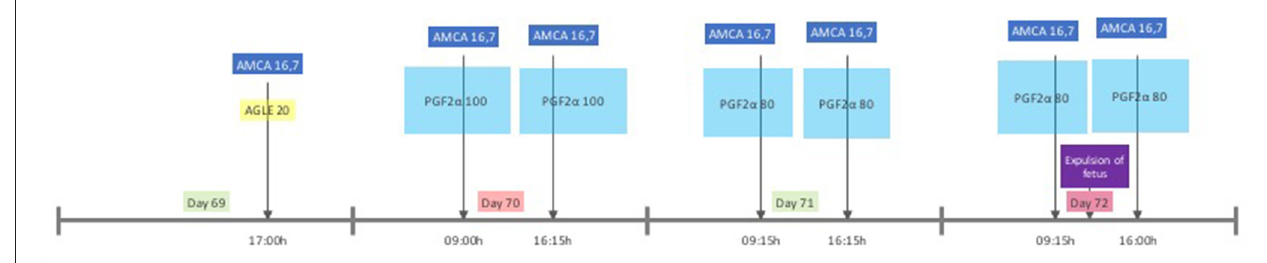
FIGURE 3 | Protocol, timeline, and dose of medical treatment. AGLE dose in mg/kg BW (SC); PGF2a dose in µ g/kg BW (IM); AMCA 16.7 mg/kg BW